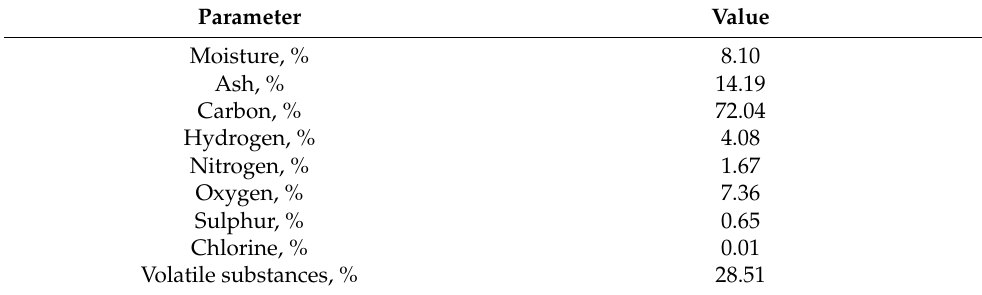
Table 3. Composition of coal fuel.